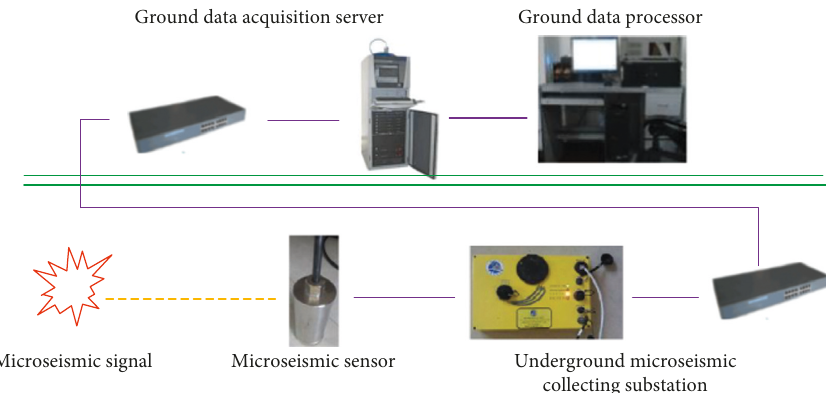
Figure 1: The flow chart for microseismic monitoring.